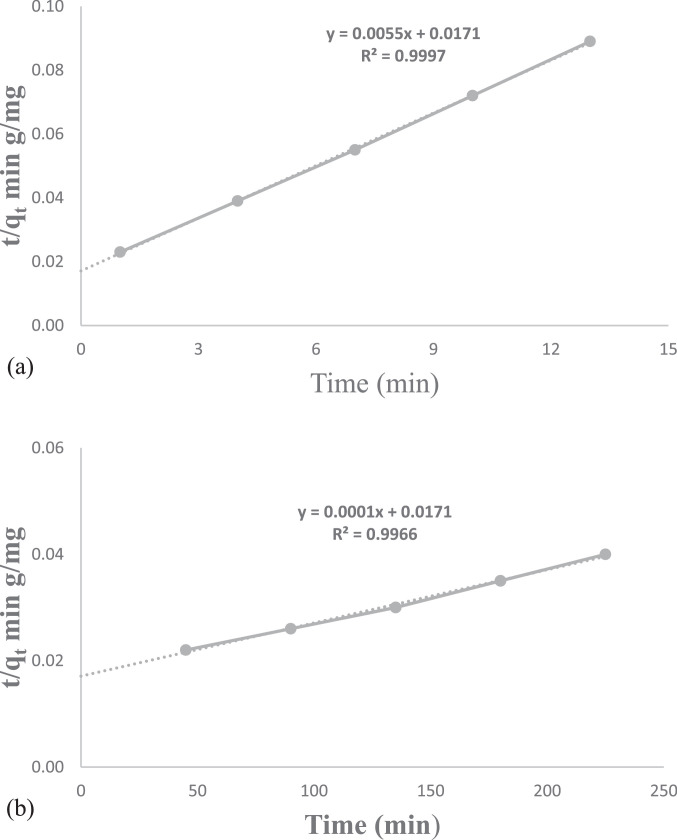
Pseudo-second order model for nanostructure on AO10 dye removal: a) TiO2/zeolite and b) BiVO4/zeolite.